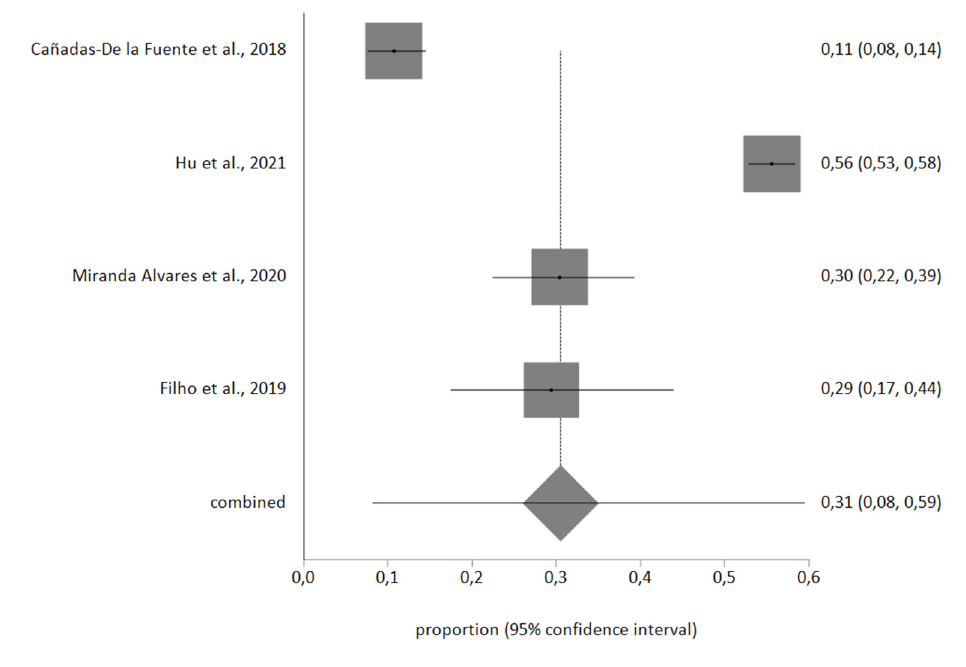
Figure 2. High EE forest plot.